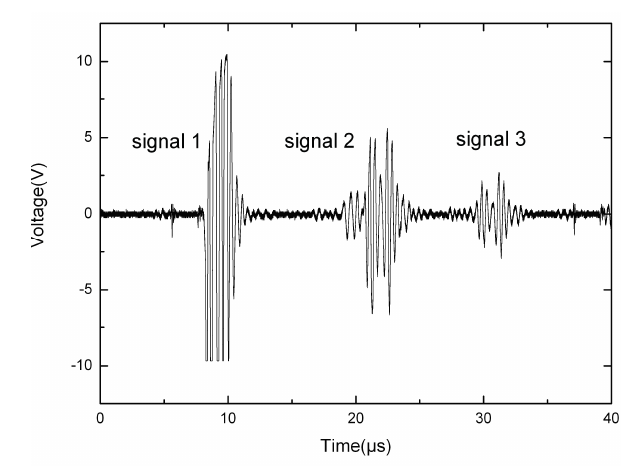
Figure 6. Block diagram of the measuring system.